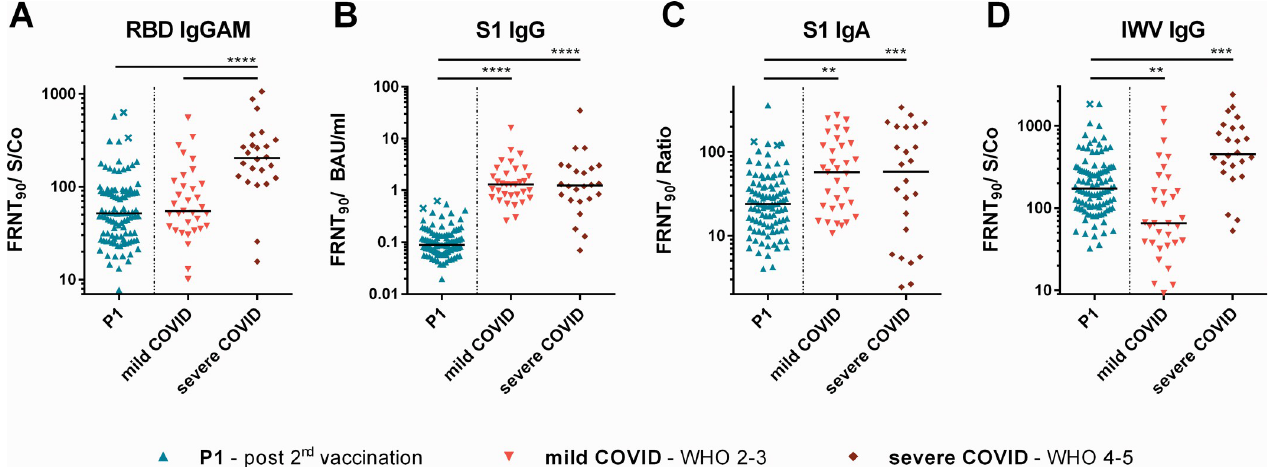
Fig 3. Ratios between SARS-CoV-2 neutralizing antibody titers and ( A, C, D ) RBD IgGAM, S1 IgA, IWV in sample/calibrator ratios and ( B ) S1 quant IgG in BAU/ml. Sera of vaccinees two weeks after second vaccination (P1) were compared with sera of COVID-19 patients with mild and severe courses according to WHO score (2–3 mild and 4–5 severe). � = p < 0.05, �� = p < 0.01, ��� = p < 0.001, ���� = p < 0.0001, ns = not